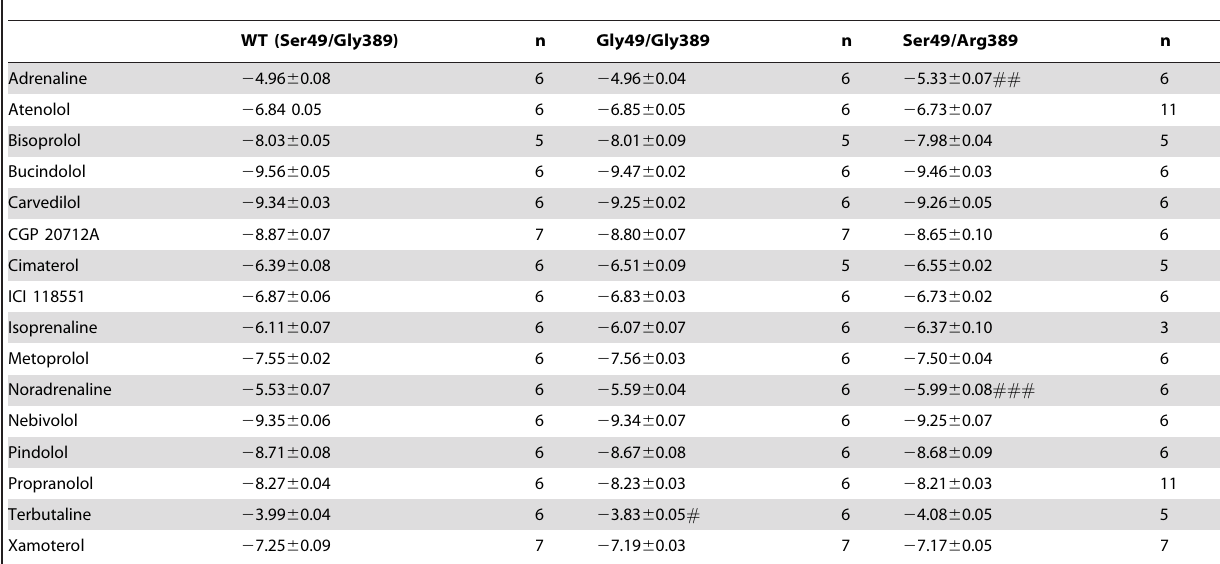
Table 1. Affinity of b -adrenoceptor ligands for the wildtype and polymorphic variants of the b 1-adrenoceptor.